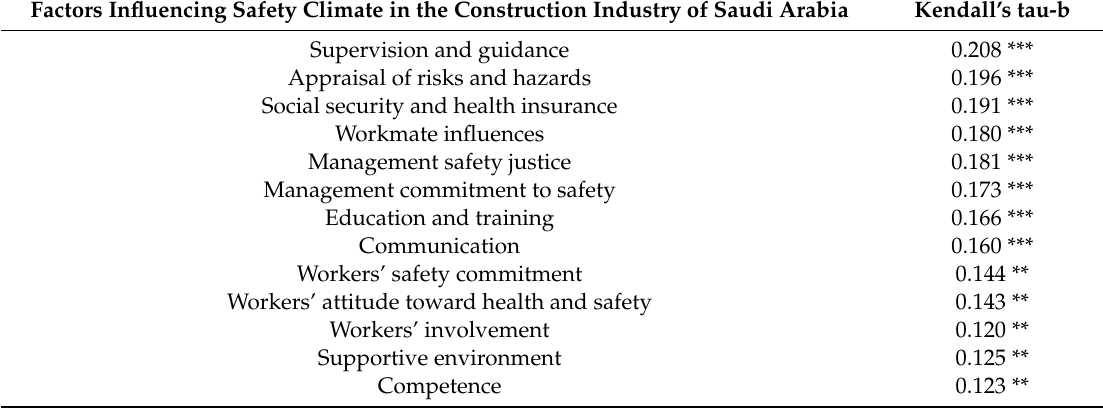
Table 7. Statistically significant correlations between the perceived importance of factors influencing safety climate and the perceived overall safety climate ratings. Factors Influencing Safety Climate in the Construction Industry of Saudi